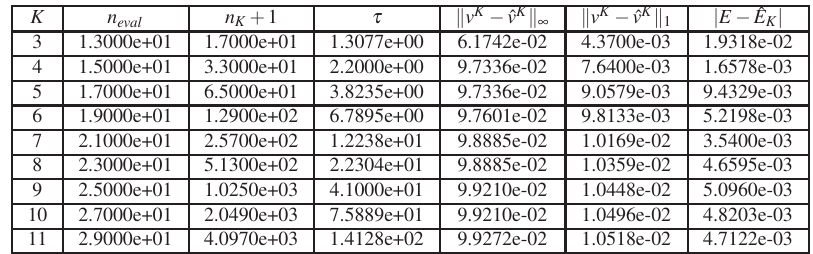
Table 5 Parameters as specified in Table 1 for f 2 , ε = ε k = 10 − 1 and the polygonal rule.